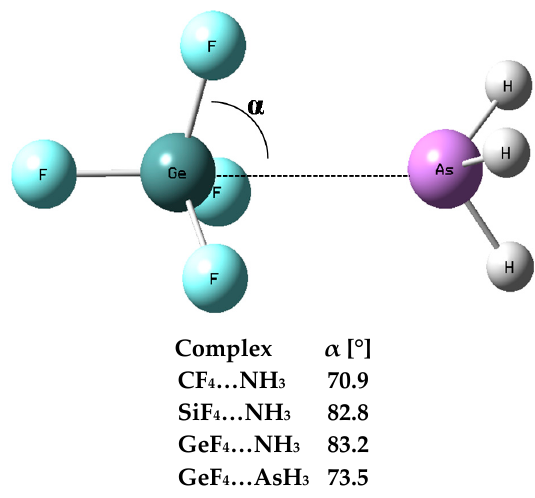
Figure 3. The definition of the α -angle, the GeF 4 …AsH 3 complex is presented as an example, the α -angles for complexes containing one ligand are given, this angle for all complexes with two ligands is equal to 90° or nearly so.